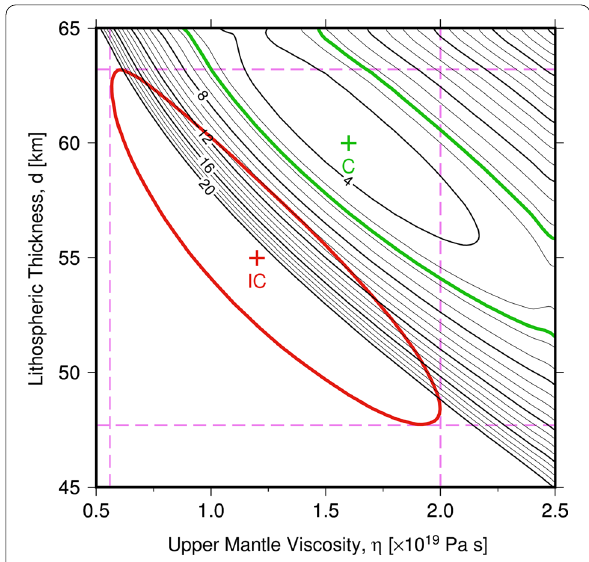
Fig. 13 Distribution of χ 2 to the variations of d and η in the compressible case. The green cross denoted by C indicates the position, where the χ 2 value reaches a minimum, and the green line indicates the 68.27 % confidence level of (η , d ) . The red lines denoted by IC show the results obtained in this study by assuming the incompressible Earth (see Fig. 7), and pink dashed lines indicate the projection of its confidence level to each axis of d and